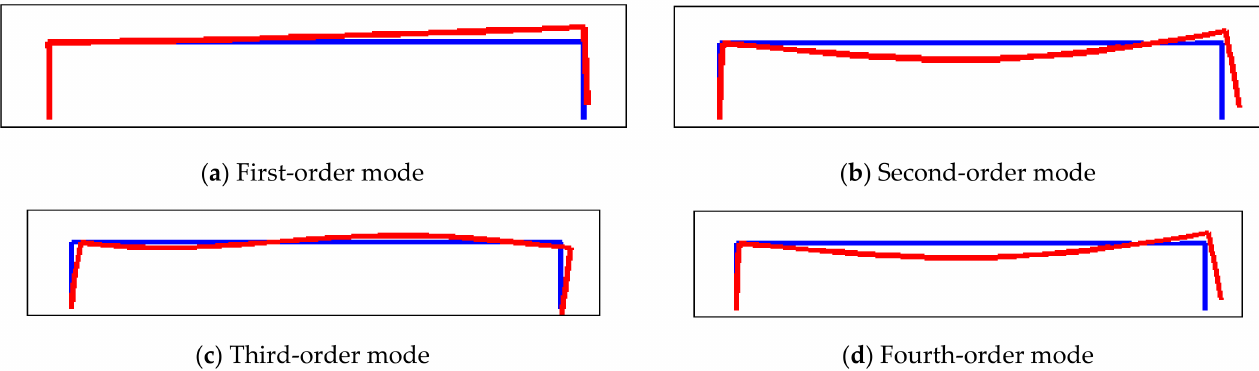
Figure 9. The mode diagram of resonator structure with single-ended fixed support: ( a ) first-order mode; ( b ) second-order mode; ( c ) third-order mode; ( d ) fourth-order mode.